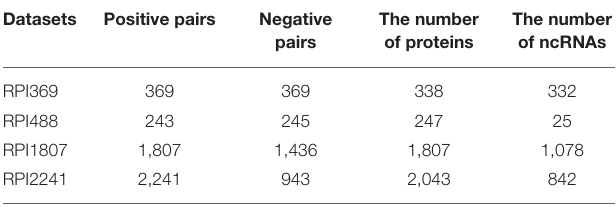
TABLE 1 | The specific composition of four required